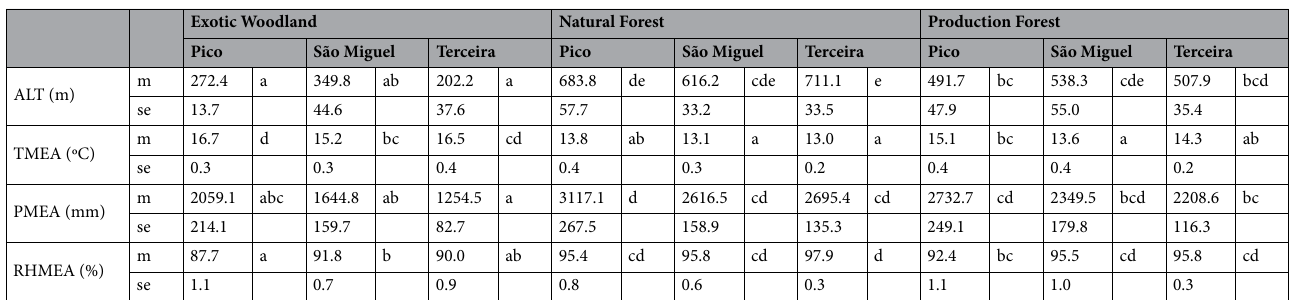
Table 4. Environmental variables found at 90 forests in the Azores, from three islands (Pico, São Miguel, and Terceira) and three forest types (Exotic Woodland, Natural Forest, and Production Forest). Mean and standard error for each environmental parameter. For each row, different letters indicate significant differences (p < 0.05) according to the results of a Tukey test applied after